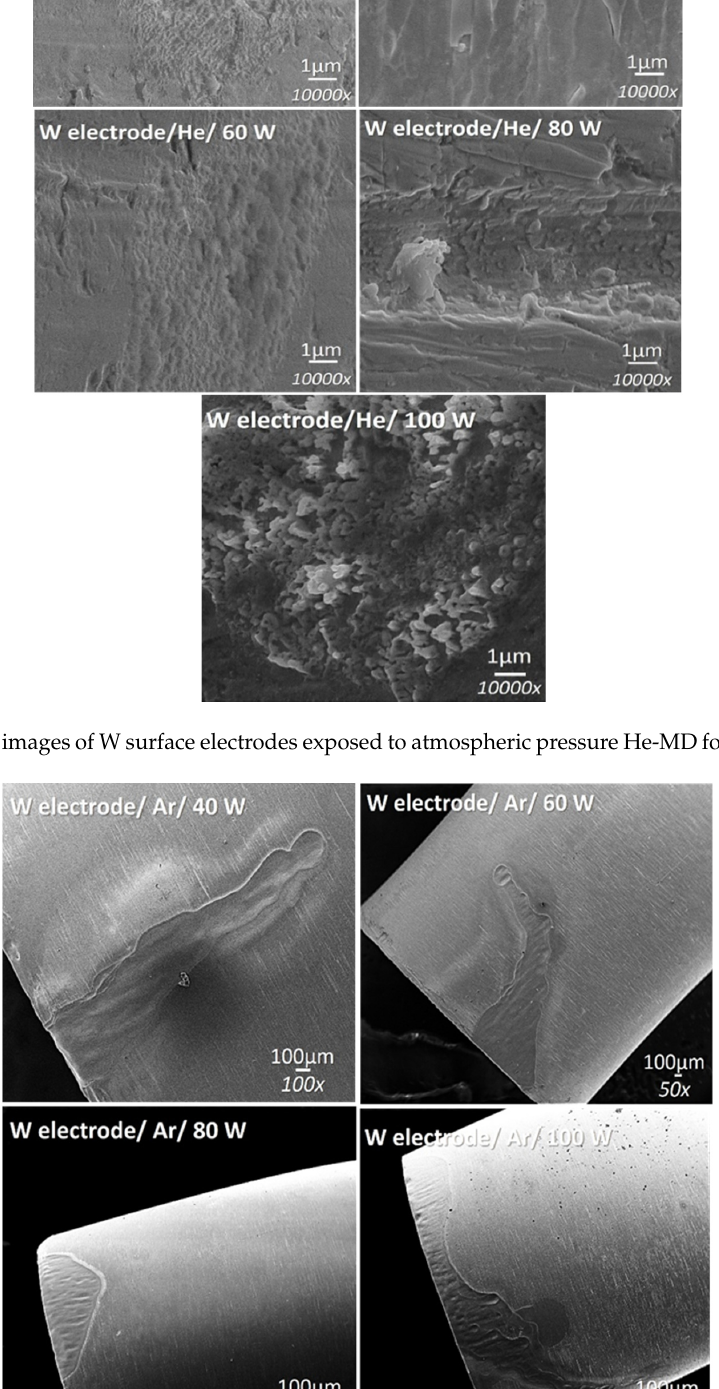
Figure 8. SEM images of W surface electrodes exposed to Ar-MD for 40 W–100 W.